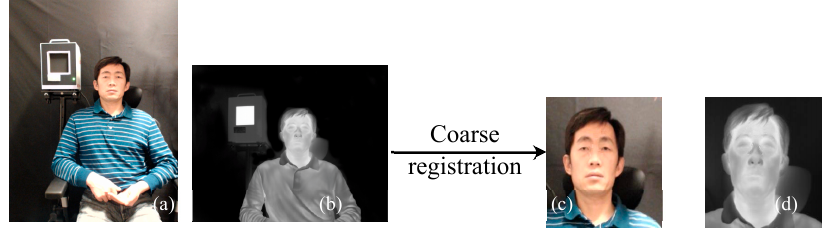
Figure 4. Visible ( a , c ) and IR ( b , d ) images before ( a , b ) and after ( c , d ) coarse registration.